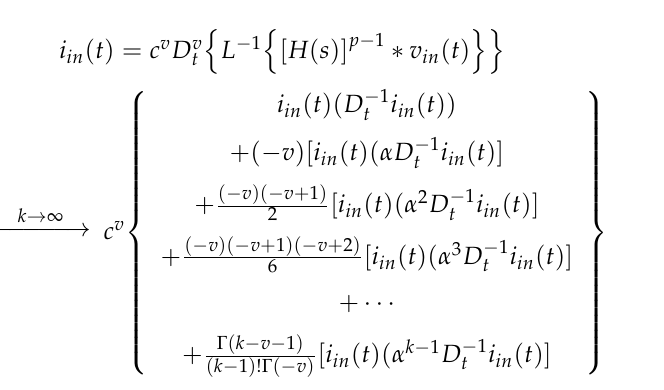
Said another way, is a scalar. Taking Equation (22) into Equation (21), we obtain Equation (23),